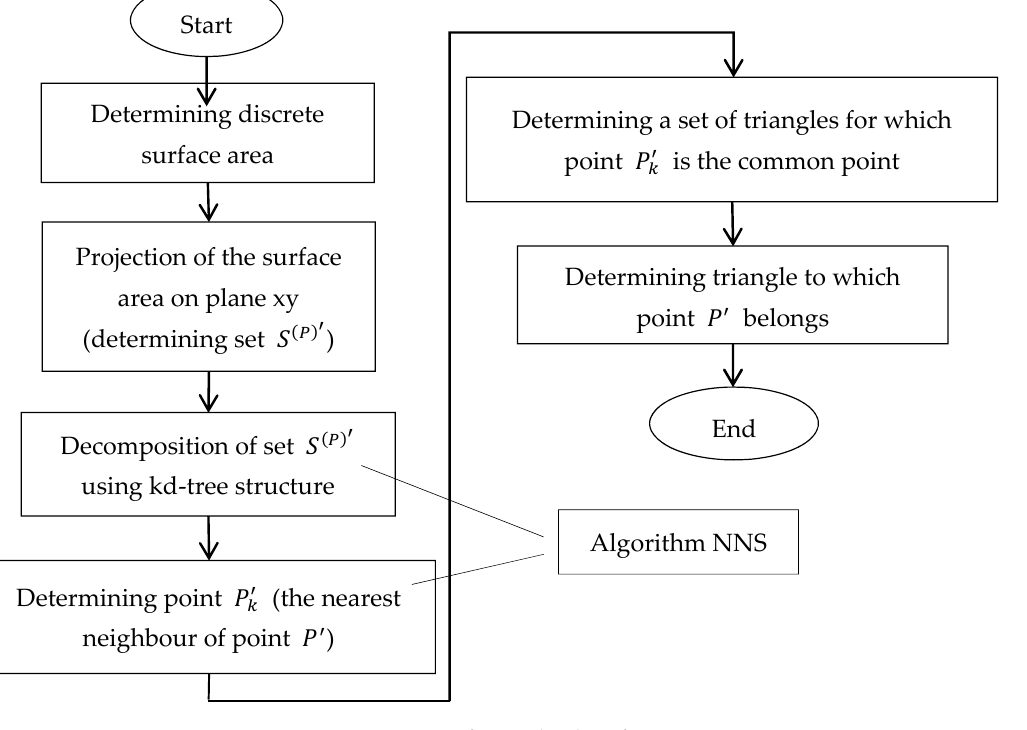
Figure 12. A graphic presentation of the final stage of the procedure while using the kd-tree structure.